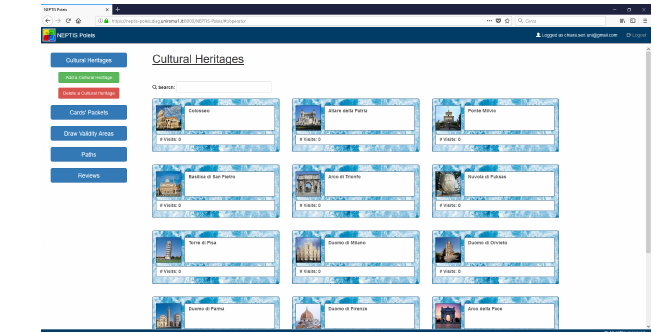
Figure 11. Cultural paths for Colosseum Figure 12. Cultural